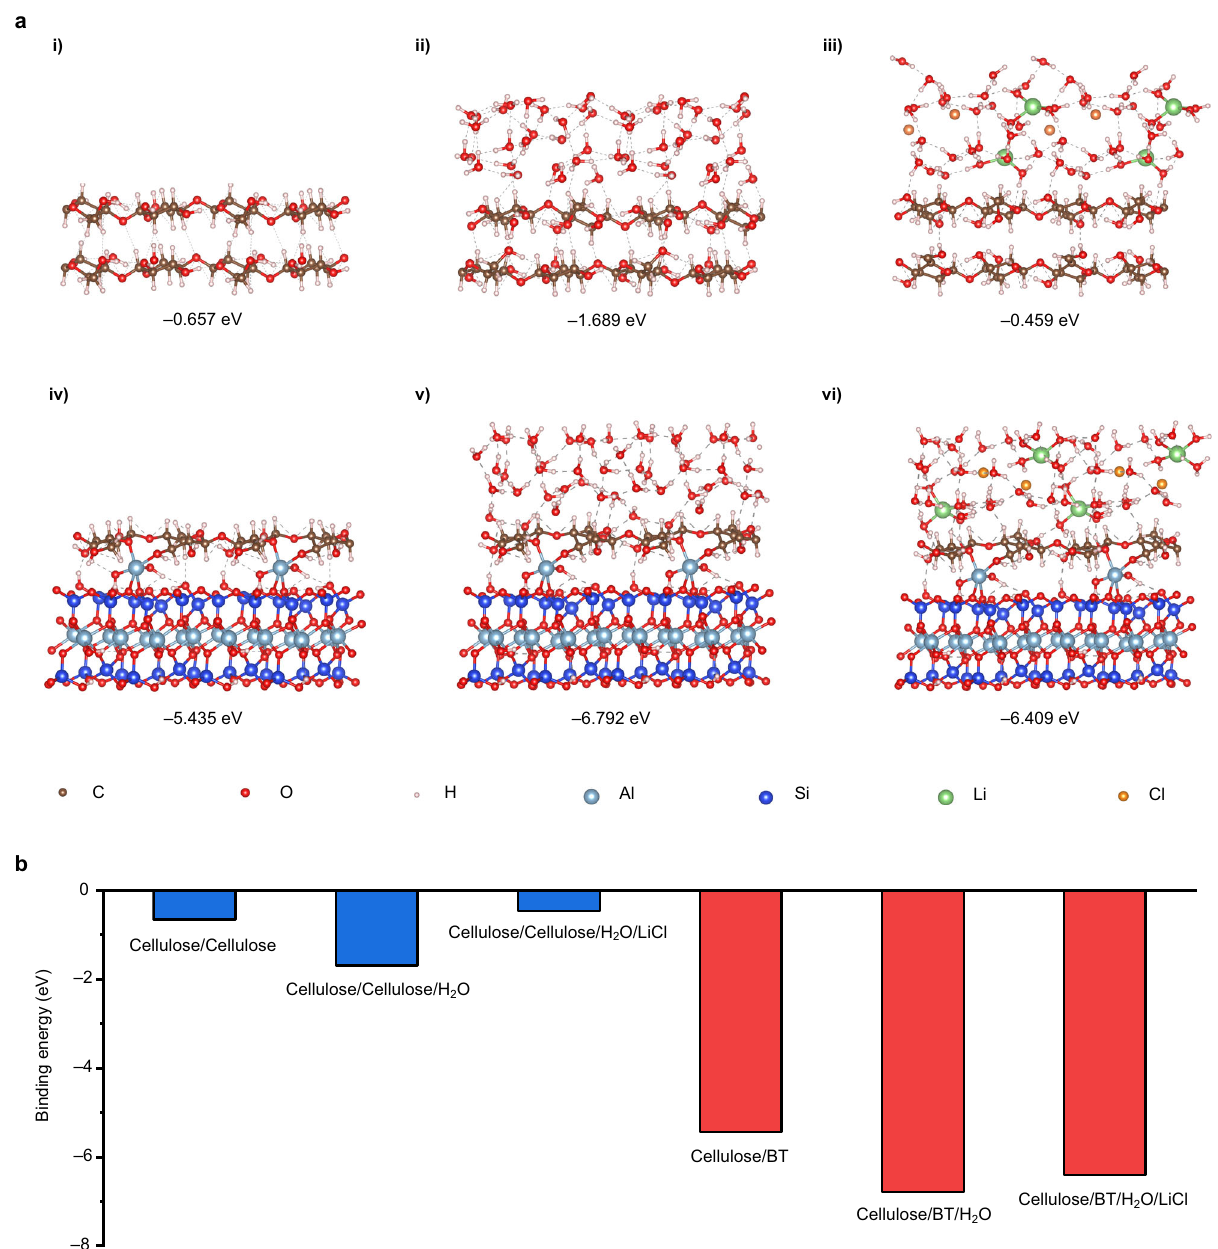
Fig. 3 Impact of BT on cellulose-cellulose and cellulose-BT interactions from DFT calculation. a Energy-optimized geometry of bonding between cellulose chains by theoretical calculation with DFT study (i – iii). The interaction between two cellulose chains in a solvent-free (i), water environment (ii), and a LiCl/H 2 O solution system (iii). Energy-optimized geometry of bonding between cellulose and BT nanoplatelets via Al substitution sites obtained by theoretical calculation with DFT study (iv – vi). The interaction between cellulose and BT nanoplatelets in a solvent-free (iv), water environment (v), and a LiCl/H 2 O solution system (vi). b The binding energy of cellulose and cellulose/BT in different environments by DFT